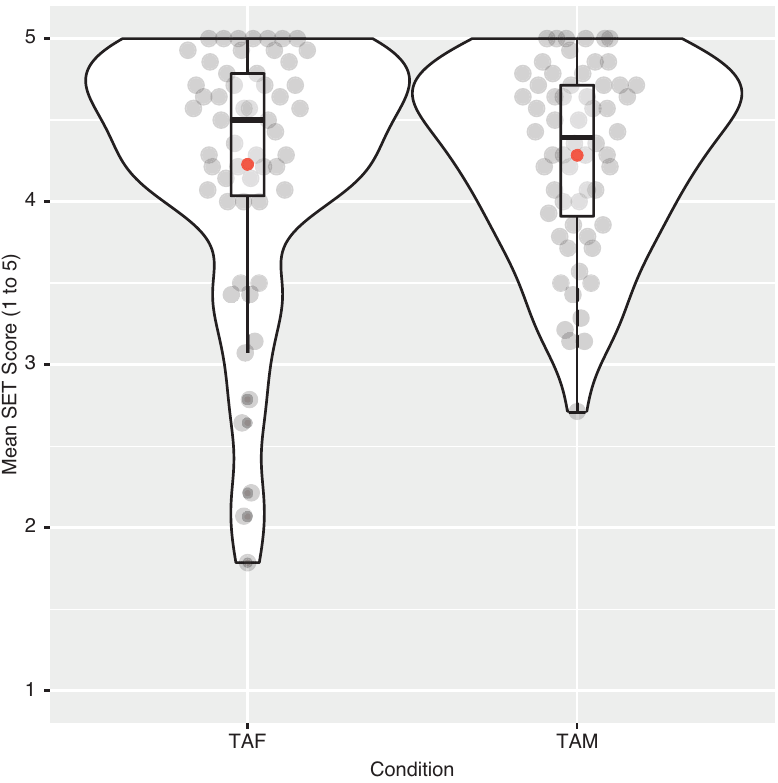
Figure 5. The violin plots of Khazan et al.’s recovered data on the original 1 to 5 Likert SET scale, for TAF and TAM conditions, with the six outliers included. The mean rating of the female TA is slightly lower than that of the male TA but the difference is trivial, 0.05. In contrast, the median rating of the female TA is higher than that of the male